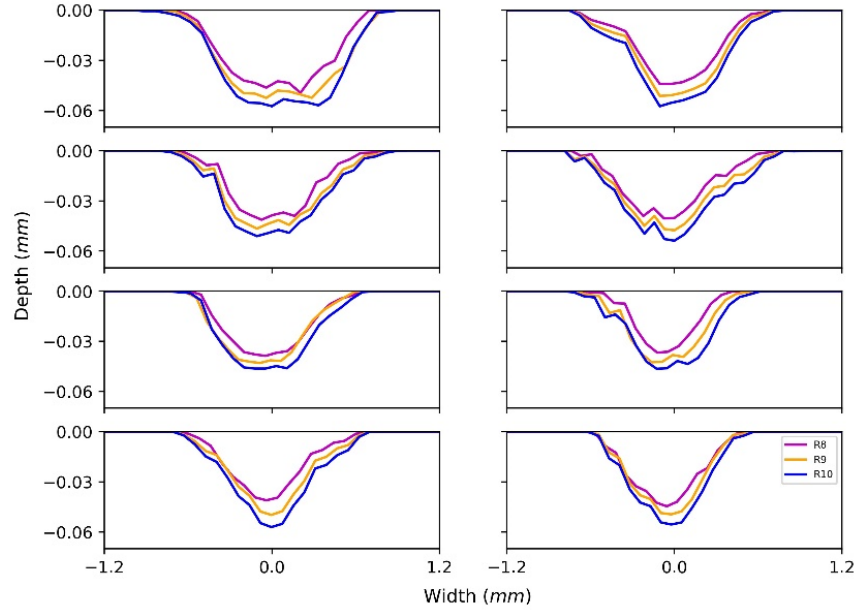
Figure 14. Examples of wear contour.